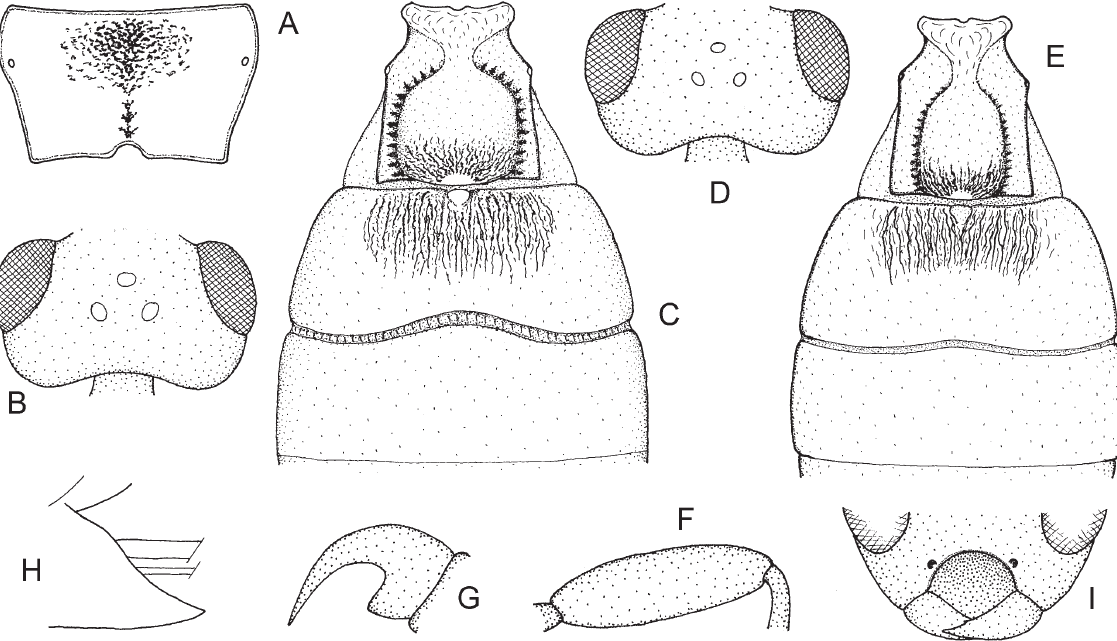
Fig. 7. — A . Bracon ( Lucobracon ) guttiger Wesmael, 1838, ♀, propodeum. — B-C . Bracon ( Glabrobracon ) pulcher Bengtsson, 1924 (♀ paralectotype). B . Head in dorsal view. C . Tergites 1-3. — D-G . Bracon ( Glabrobracon ) subsinuatus Szépligeti, 1901, ♀. D . Head in dorsal view. E . Tergites 1-3. F . Hind femur. G . Claw. — H . Bracon ( Lucobracon ) larvicida Wesmael, 1838, ♀, hypopygium and ovipositor apparatus. — I . Bracon ( Lucobracon ) sphaerocephalus Szépligeti, 1901, ♀, head in frontal